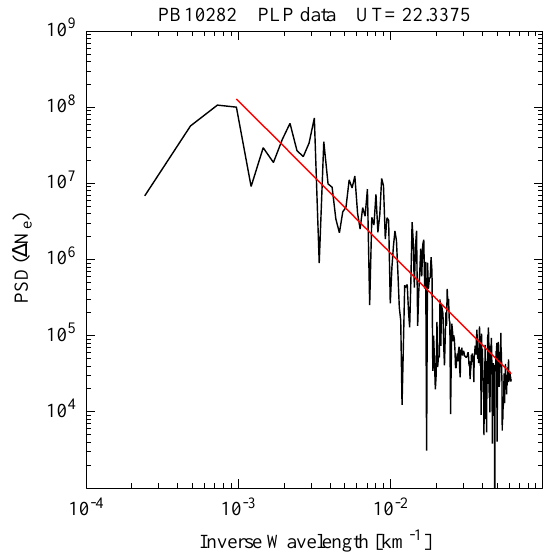
Fig. 4. Power spectrum of the density irregularities around 18:00LT in Fig. 3, illustrating their power-law-like nature, close to k − 2 (the straight line in this log-log plot). The 1-Hz sampled PLP data were used for the spectral analysis; k is the inverse of the wavelength in